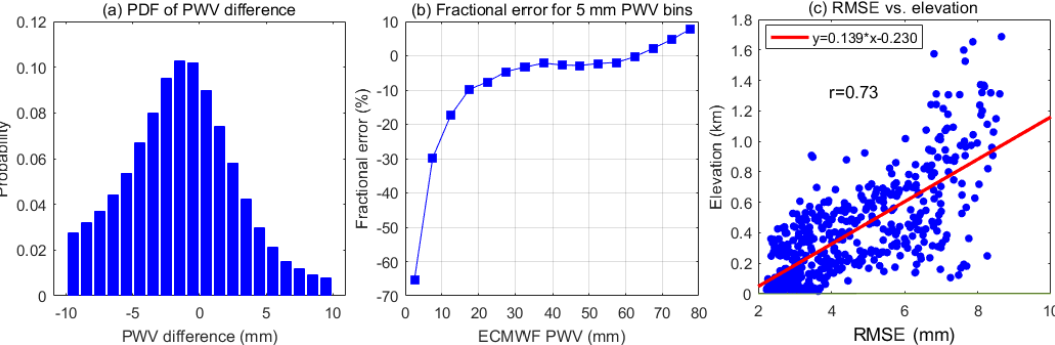
Figure 7. (a) PDF of PWV difference, (b) fractional error as percent by ERA-I 5mm PWV bins, and (c) relationship between RMSE and elevation for the comparison between ERA-I and